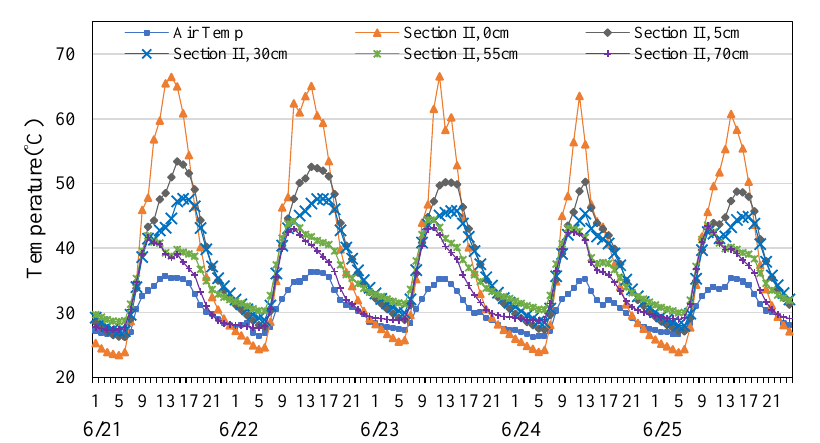
Figure 7. Temperature distribution at each depth of Section II from the 21st to the 25th of June.